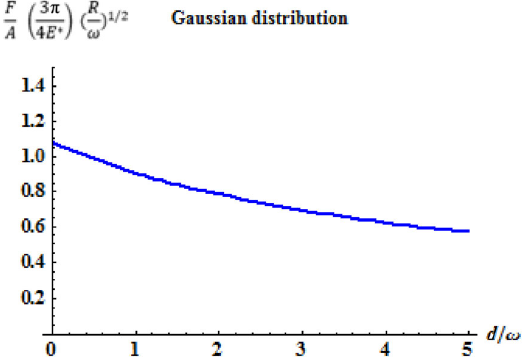
Fig. 2 The pressure of contact as separation of surfaces when the Gaussian distribution is summits’ distribution. Clearly, the friction coefficient is not independent of the load, though there is the almost constant behavior for the range of (2.5 ω − 5 ω